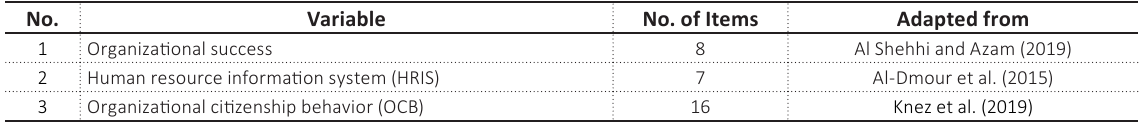
Table 1. Measurement instruments